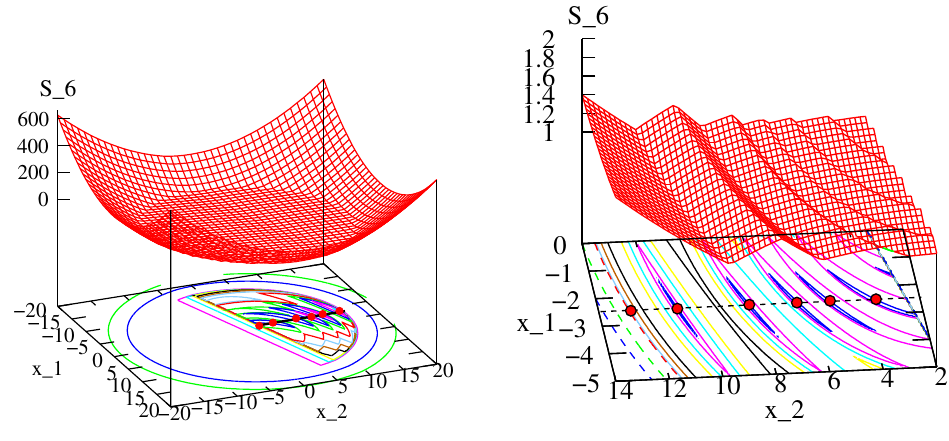
( b ) The function S 6 surface is blown up near the opti- mal region showing six optima.